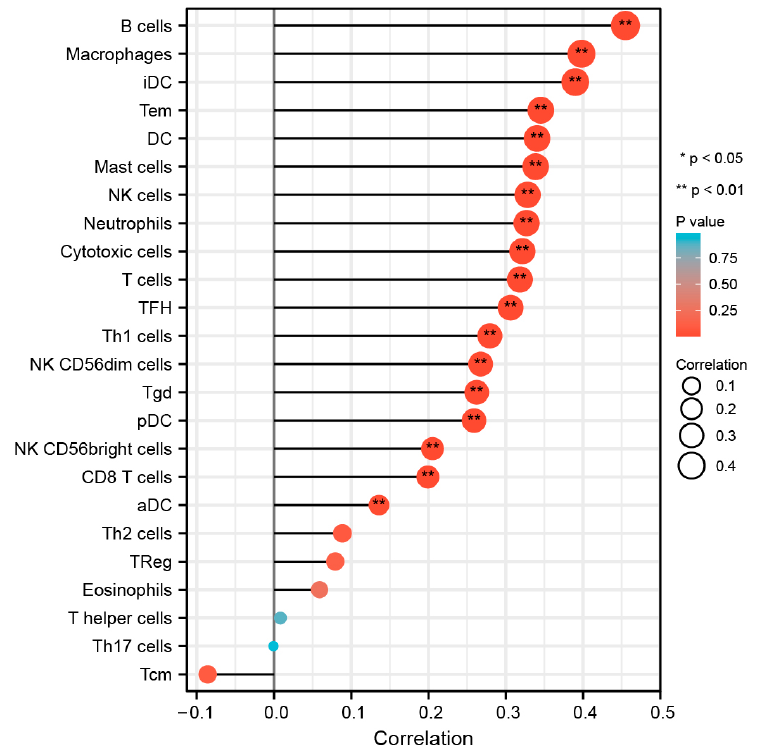
Figure 8. Correlation of HAMP expression with the infiltration of 24 immune cells.